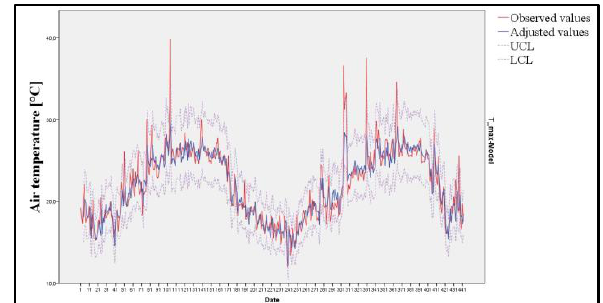
Figure 6. Time series curve of Tmax from 2011 to 2012 (UCL: Upper Control Limit; LCL: Lower Control Limit).